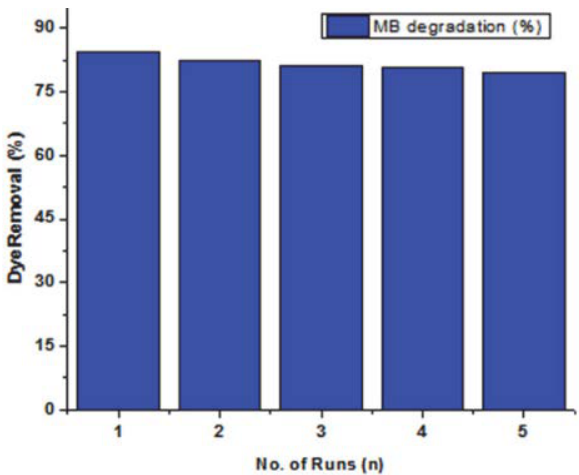
Figure 10. Recyclability of ZNG-4 in Photodegradation of MB dye (upto 5